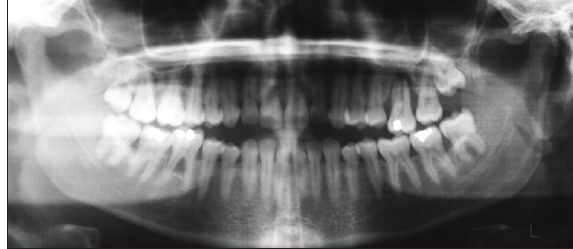
Figure 4. Pretreatment lateral cephalogram.